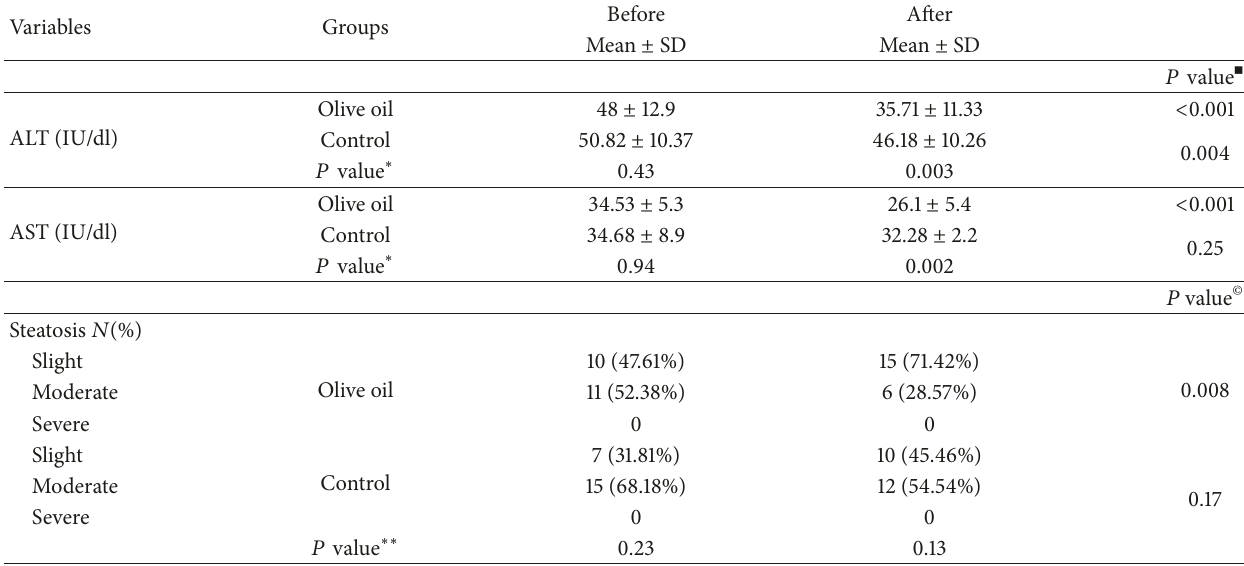
Table 4: Aminotransferase and severity of steatosis at the start and the end of